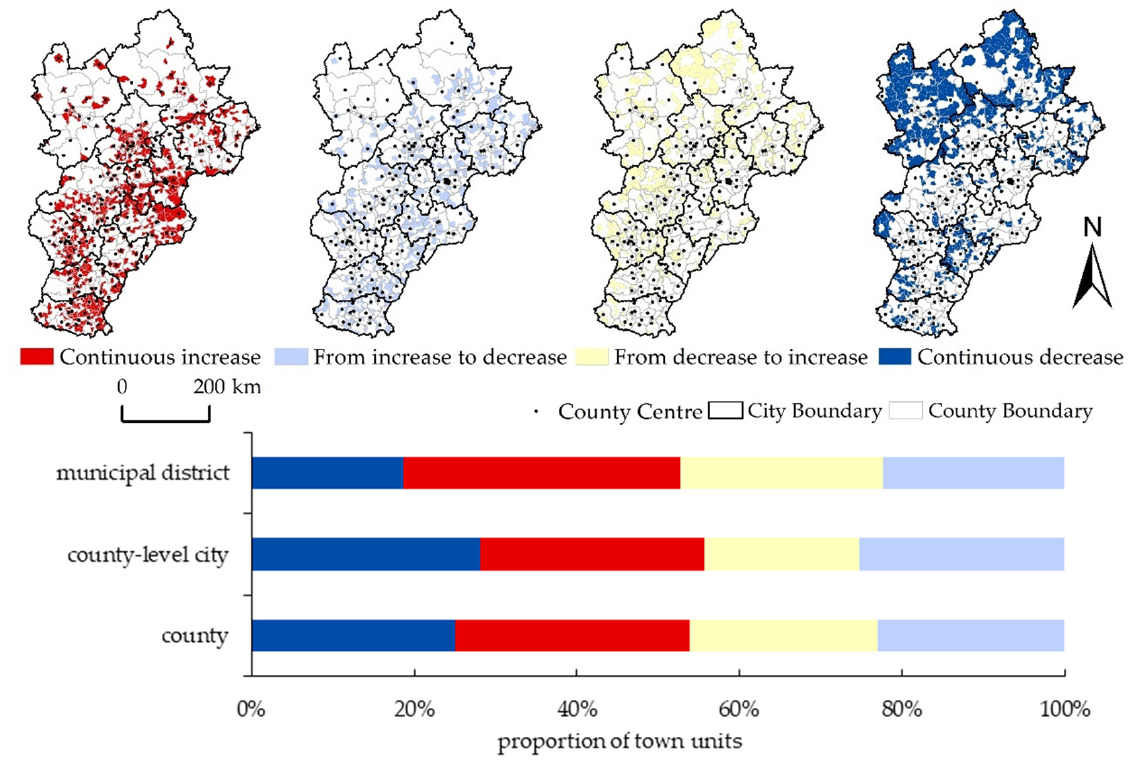
Figure 7. Types of population changes and the proportion of various types.